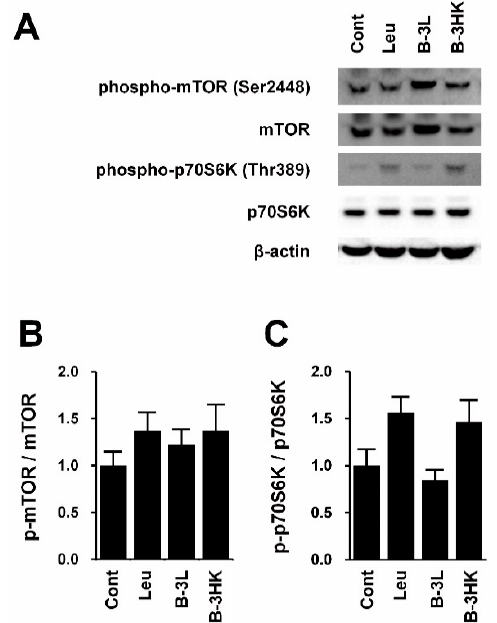
Figure 2. The effects of B-3 on Akt activation in the soleus. Representative bands and the expression ratio of pAkt to Akt in the soleus are shown ( n = 9, 10). Difference was analyzed for statistical significance using Mann–Whitney U test (* p < 0.05). The data are expressed as the means and SEs.